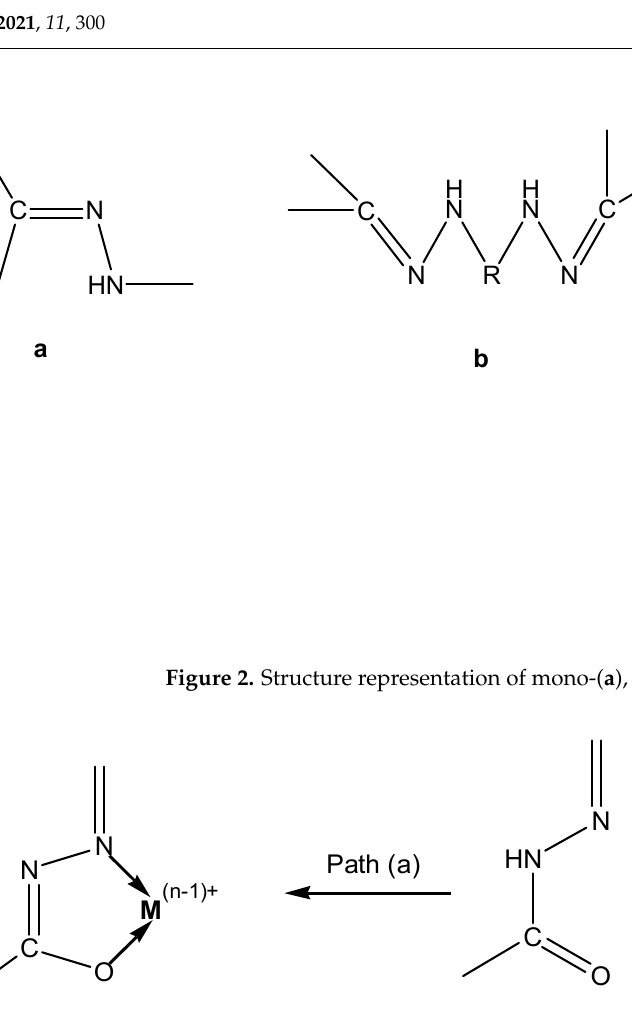
Scheme 2. The bonding of hydrazone ligands with transition metals ( a ) enolic, ( b ) ketonic.